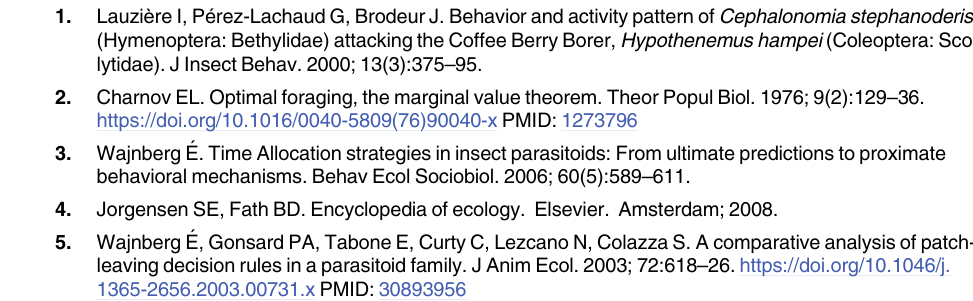
S2 Fig. Supplementary material—Experimental setup. S1 Table. Regressions